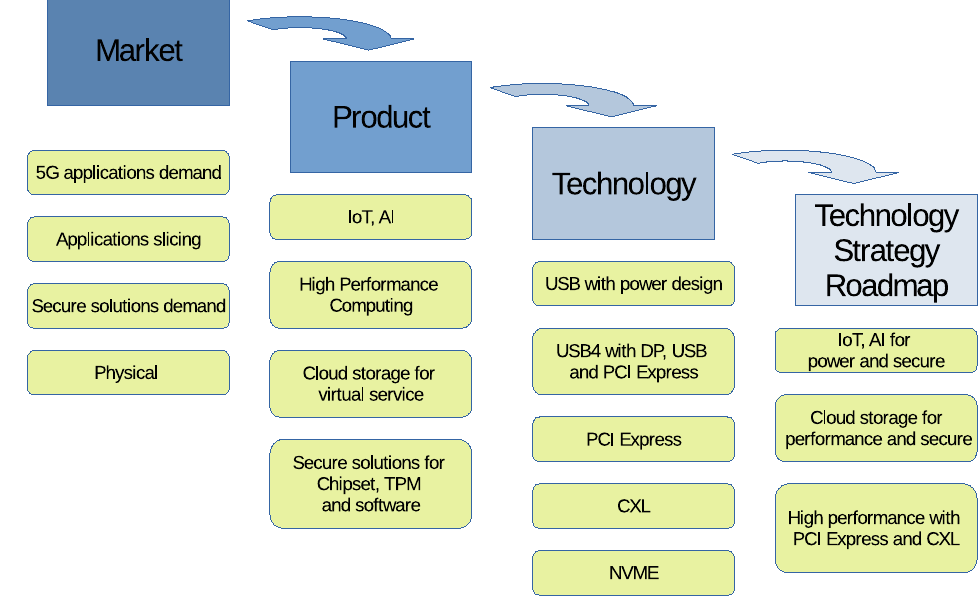
Figure 15. Process for T-Plan. Source: Technology Roadmapping